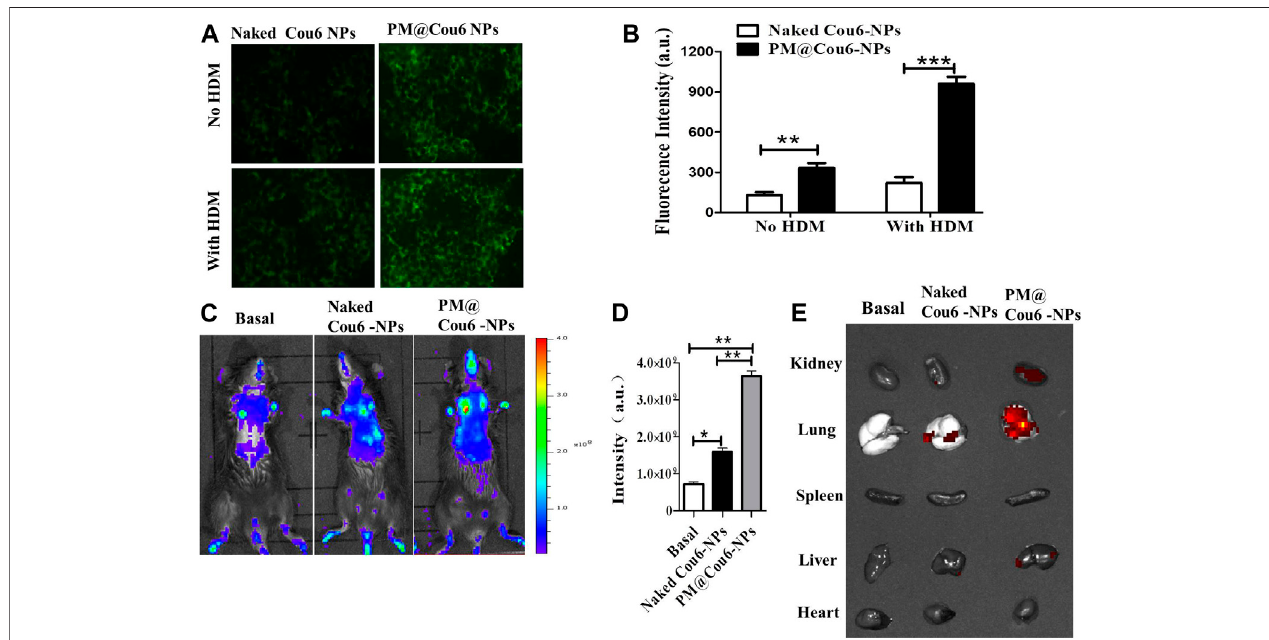
FIGURE 2 | Enhanced retention of drugs in murine in fl ammatory lungs via biomimetic modi fi cation of NPs with PM. Cou6 was encapsulated into the NPs as a fl uorescence marker. (A) The intracellular uptake of Cou6-NPs and PM@Cou6-NPs in A549 cells with or without HDM treatment. (B) The fl uorescence intensity in A549 cells cocultured with Cou6-NPs and PM@Cou6-NPs. (C) Biodistribution of naked Cou6-NPs without modi fi cation and PM@Cou6-NPs, determined bythe IVIS imaging system. (D) Themean fl uorescenceintensity(MFI)ofNPsinthelungs,determinedbytheIVISimagingsystem( n (cid:1) 3). (E) BiodistributionandretentionofPM@blank- NPs, naked Cou6-NPs without modi fi cation, and PM@Cou6-NPs in organs, determined by IVIS imaging system at 2 h after NP intranasal administration. * p < 0.05; ** p <